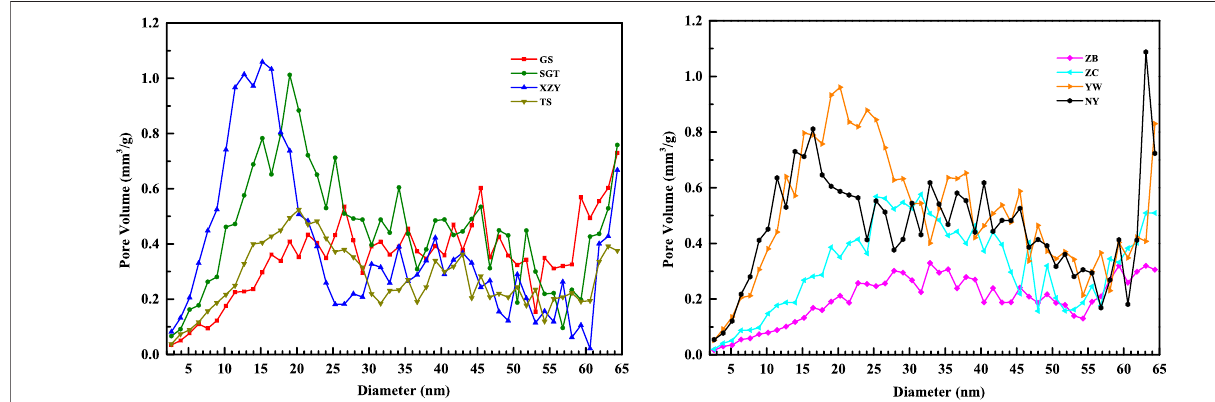
FIGURE 4 | Pore size distribution of coals with different ranks.